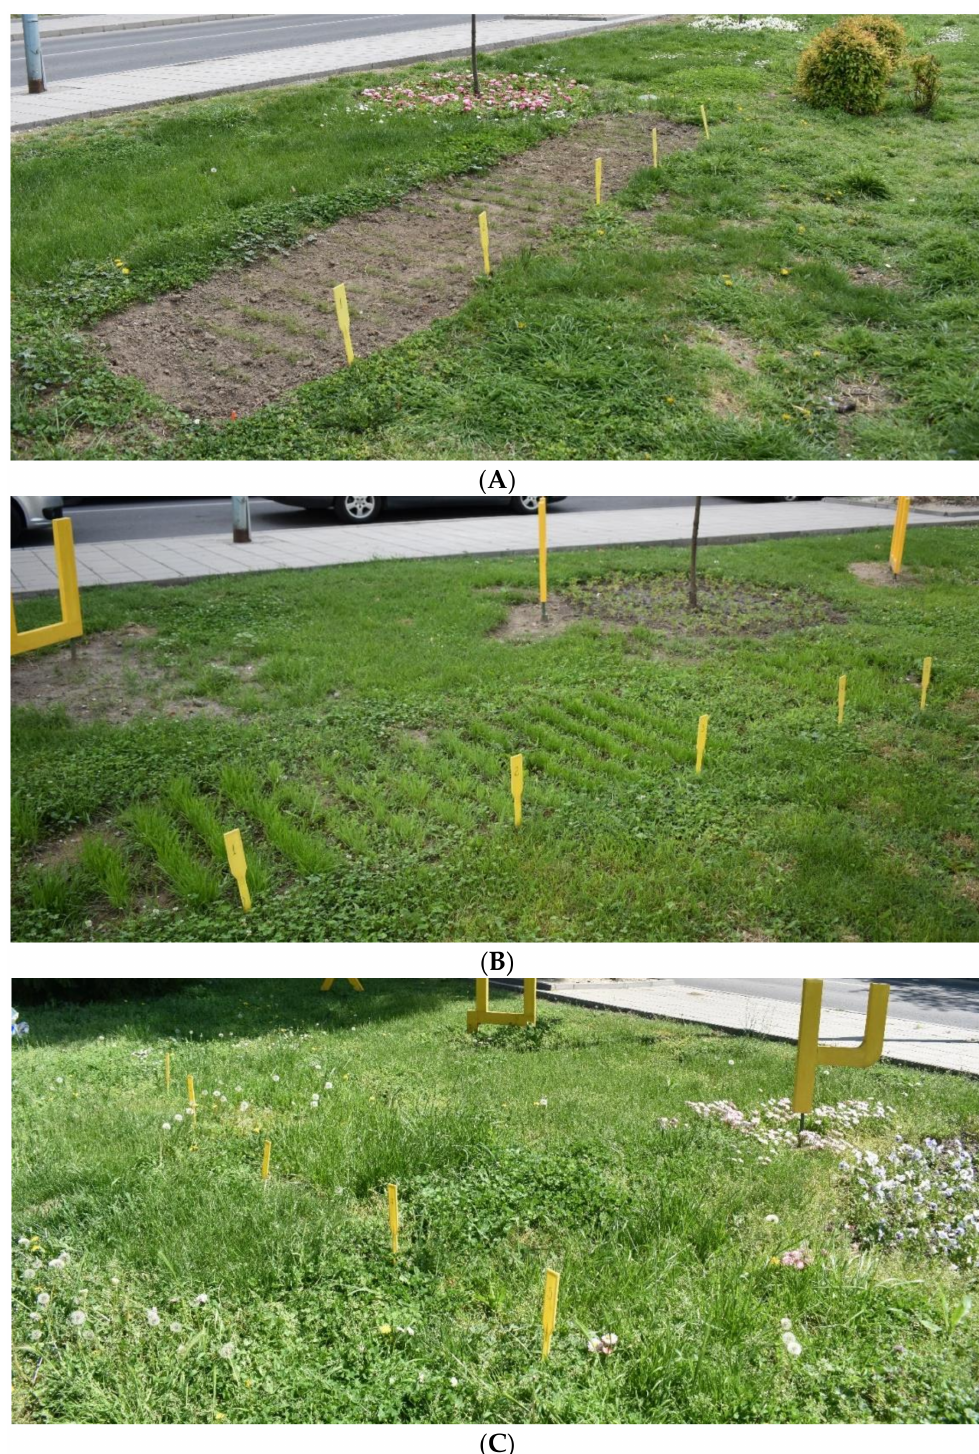
Figure 1. One of the experimental plots shown 30 days ( A ), 60 days ( B ), and 90 days ( C ) after sowing. Microbiological analyses were scheduled to be performed within 24 h after sampling. For this purpose, 1 g of soil from each subplot was placed in 99 mL of sterile distilled water. The sample was homogenized for 30 min at 200 rpm to separate the cells from the soil particles. A semi-automatic Stuart SC6 + counter (BioCote, Coventry, UK) was used to count the colonies that formed. The number of viable microorganisms was determined by counting the number of colonies formed after inoculation on agar at 22 ◦ C over a 7 day